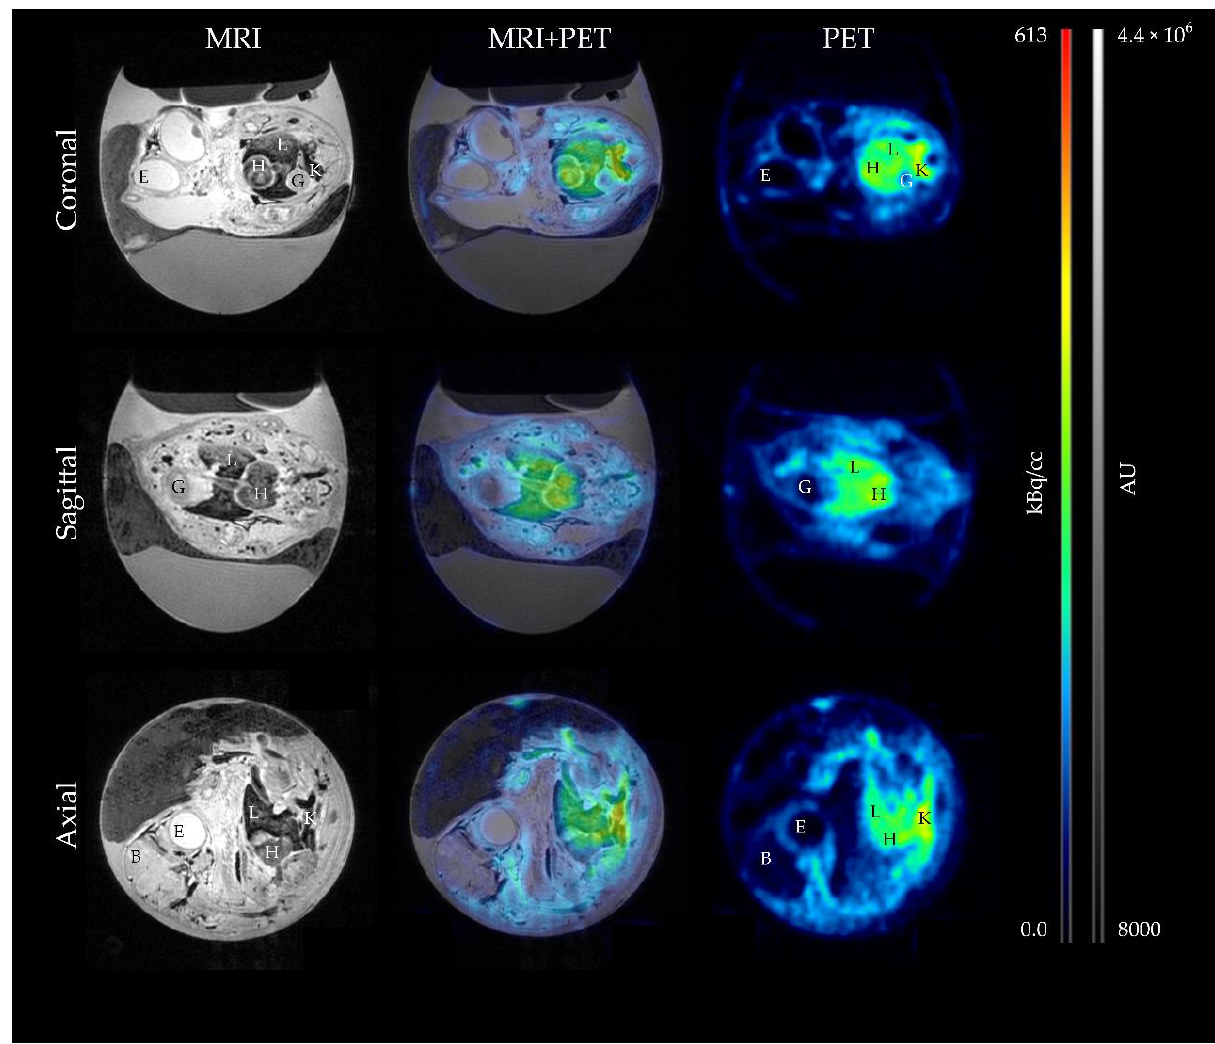
Figure 5. Biodistribution of [ 18 F]F-siPSMA-14 in the HET-CAM model visualized by MR and PET imaging. Using anatomical T1-weighted MRI ( left column ), organs can be differentiated in the chick embryo. In the PET images ( right column ), the distribution of [ 18 F]F-siPSMA-14 is visualized. By superimposing MRI and PET, the accumulation can be assigned to the respective organs. In the different sectional planes (coronal, sagittal, and axial, where axial was defined to be the main axis in the chicken egg), it is evident that there is no signal in the eye (E), brain (B), or gizzard (G). Accumulation of radioligand is observable in liver (L) and heart (H) while the most intense signal is observable in the kidneys (K). PET signal is presented in kBq/cc and MRI intensity in arbitrary units